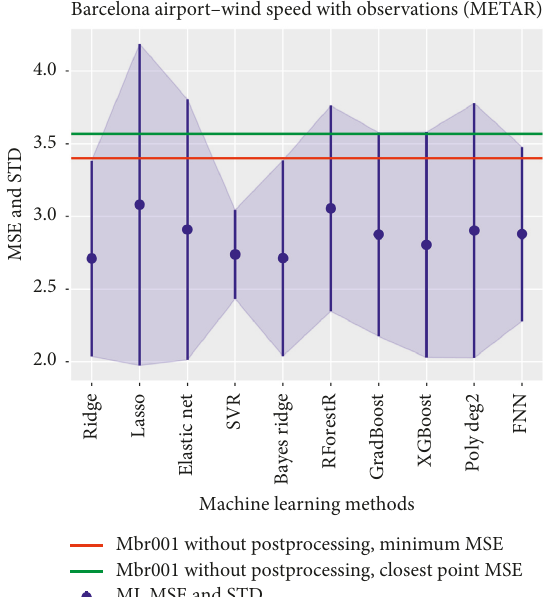
Figure 13: 10meters total wind calibration plot for Barcelona airport. Horizontal axis as in Figure 12.